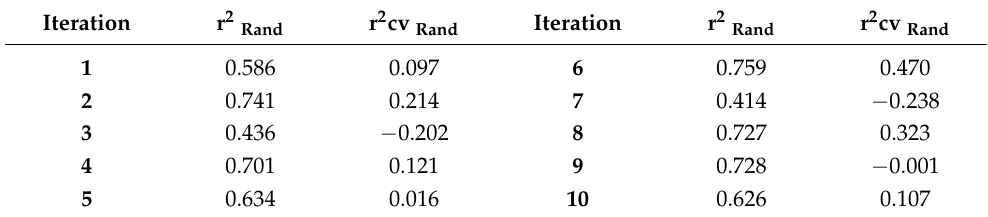
Table 4. r 2 and r 2 cv values after several Y-randomization tests